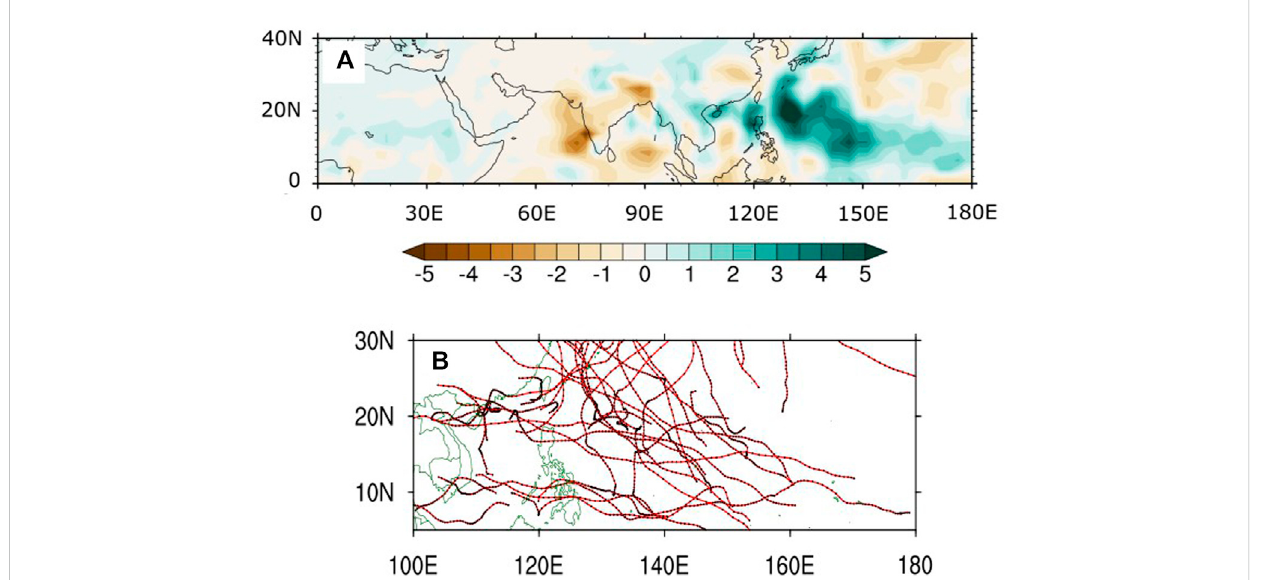
FIGURE 1 Spatial maps during the 2018 boreal summer monsoon season (JJAS): (A) Rainfall anomaly from GPCP precipitation dataset (B) Cyclone tracks over WNP from IBTrACS. The rainfall anomaly is relative to the 1991 – 2020 baseline